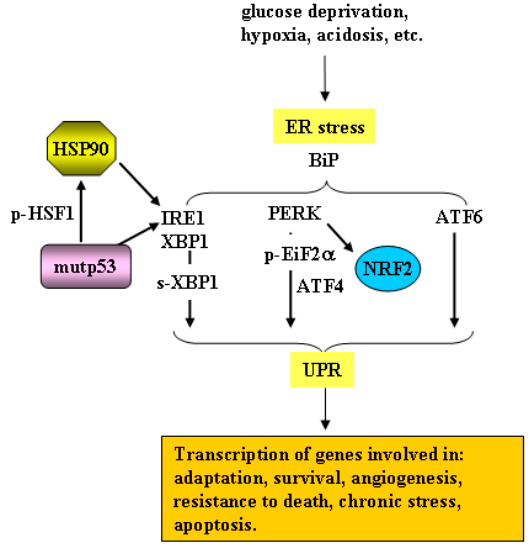
Figure 2. Molecular mechanisms of ER stress unfolded protein response (UPR) pathways. Following internal or external stimuli that induce ER stress, BiP detaches from the three main sensors of UPR, localized at the ER membrane, and active them: inositol-requiring enzyme 1 α (IRE1 α ), PKR-like ER kinase (PERK), and activating transcription factor 6 (ATF6). IRE1 α activation induces XBP1(S) transcription factor, PERK phosphorylates and activates NRF2 and eIF2 α , ATF6 is translocated to and is processed at the Golgi apparatus to create a highly active transcription factor. All three transcription factors upregulate chaperones and specific targets genes involved in protein folding, antioxidant response, autophagy, and apoptosis, to restore ER homeostasis or to induce cell death pathways. HSP90, which is involved in mutp53 stabilization, may modulate UPR through its association with the cytoplasmic domain of IRE1 and PERK. Mutp53 may activate HSF1 to promote HSP90 induction, highlighting a link between mup53, HSF1 / HSP, and UPR.